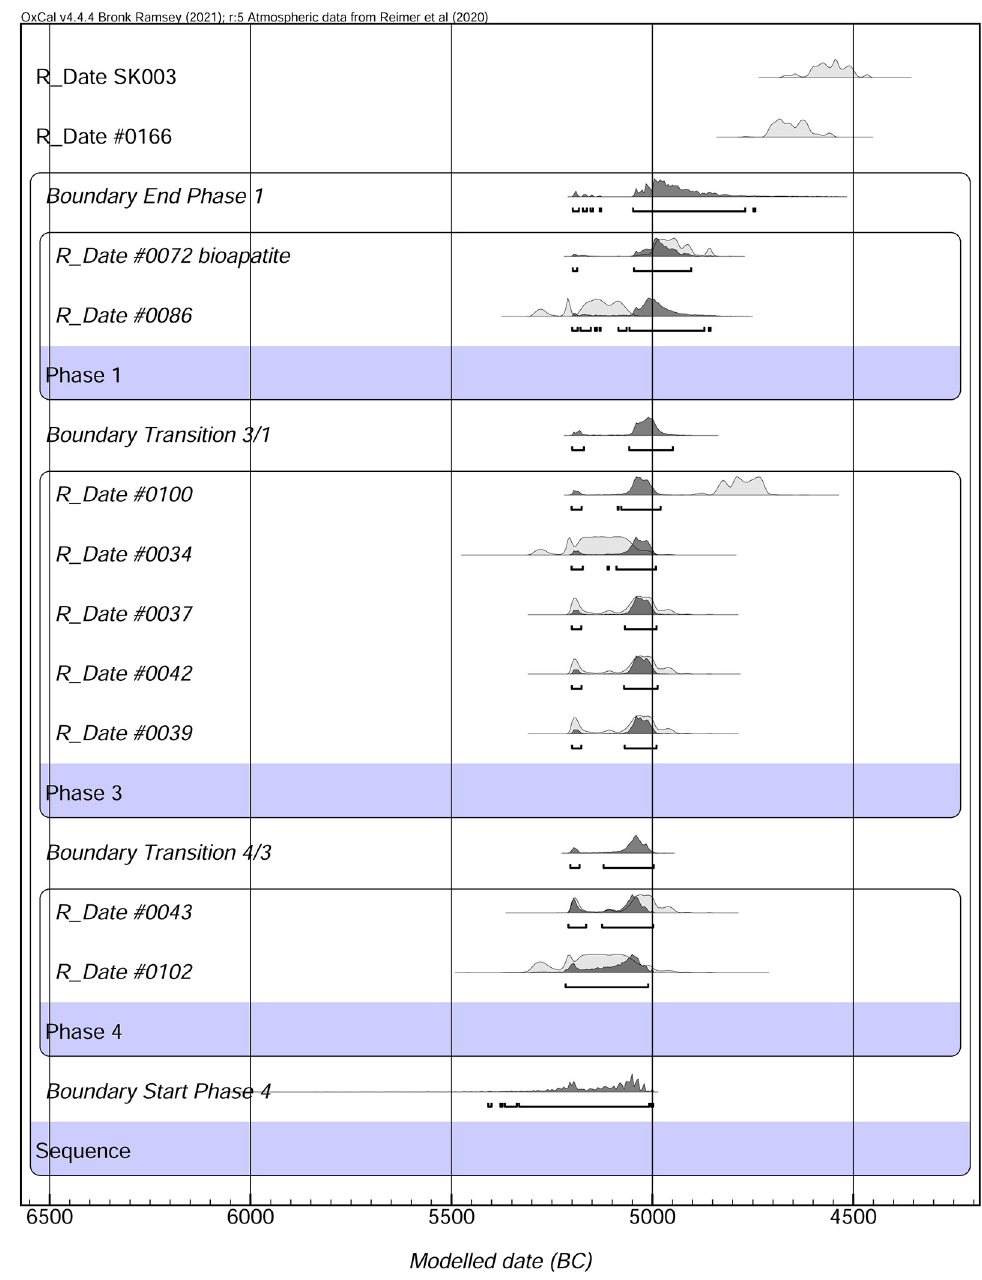
Fig 20. Radiocarbon dates for all features within site IDIHA-0008222 in cal BC. OxCal v4.4.4 Bronk Ramsey [21]; r:5 Atmospheric data from Reimer et al.